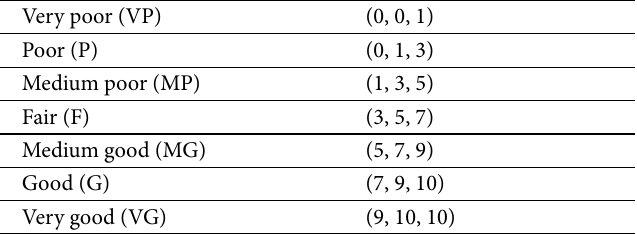
Table 2. Linguistic variables for the